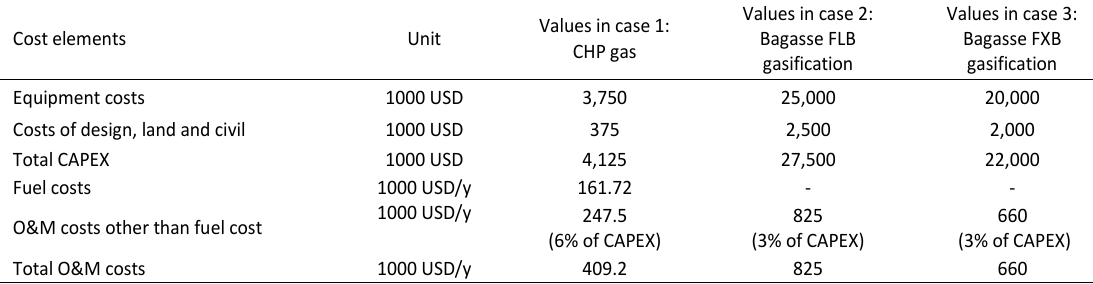
Table 3: Costs estimated for 10-MW power plants in the studied cases Cost elements